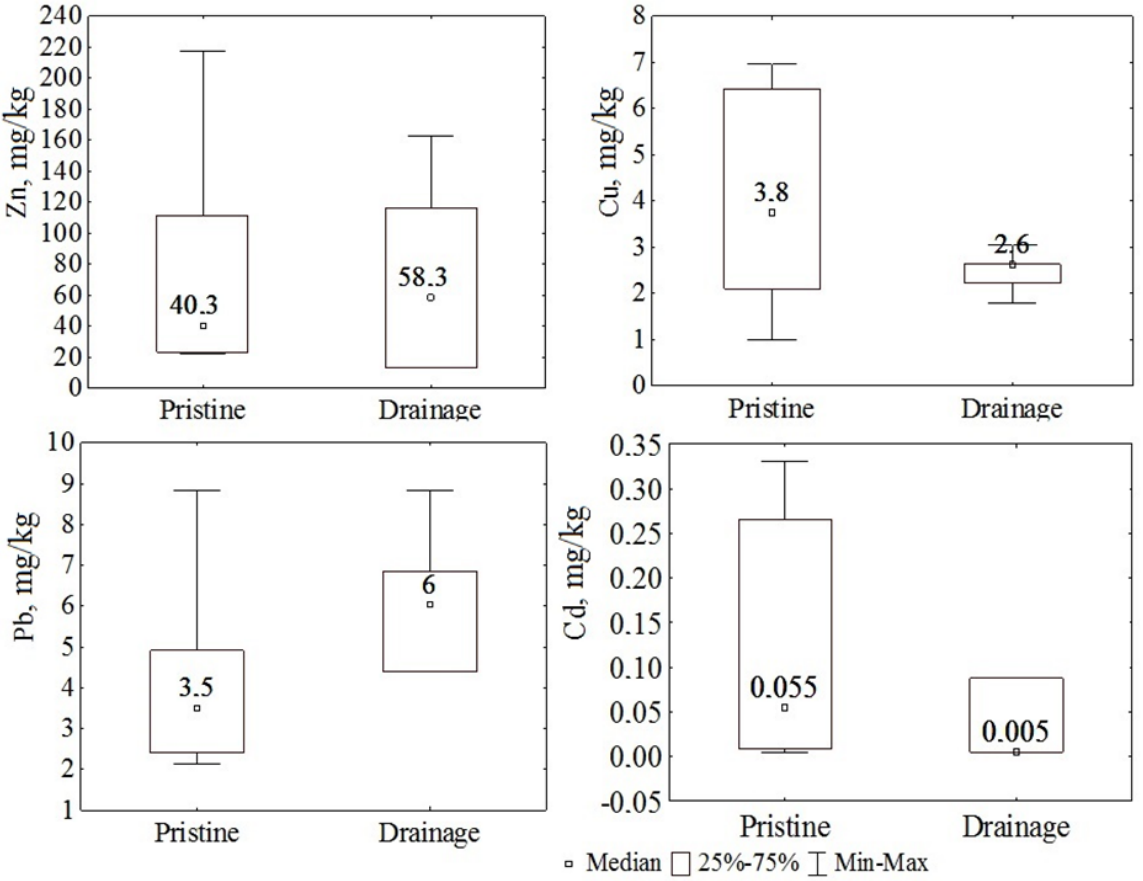
Figure 2. Element content of the peat (dry weight, mg/kg) compared between pristine and drained areas of the